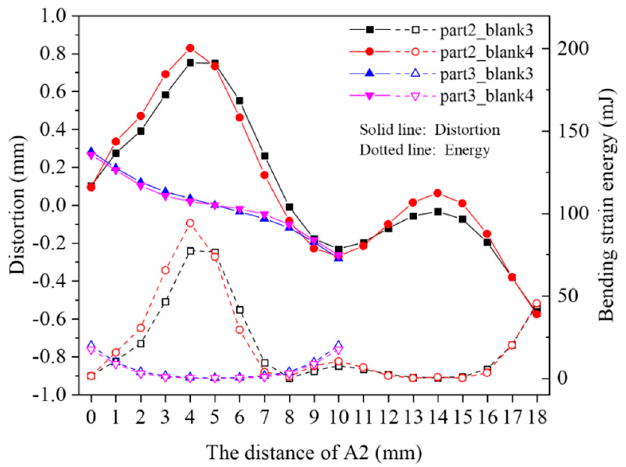
Figure 13. Comparison of the distortion of part 2 and part 3.